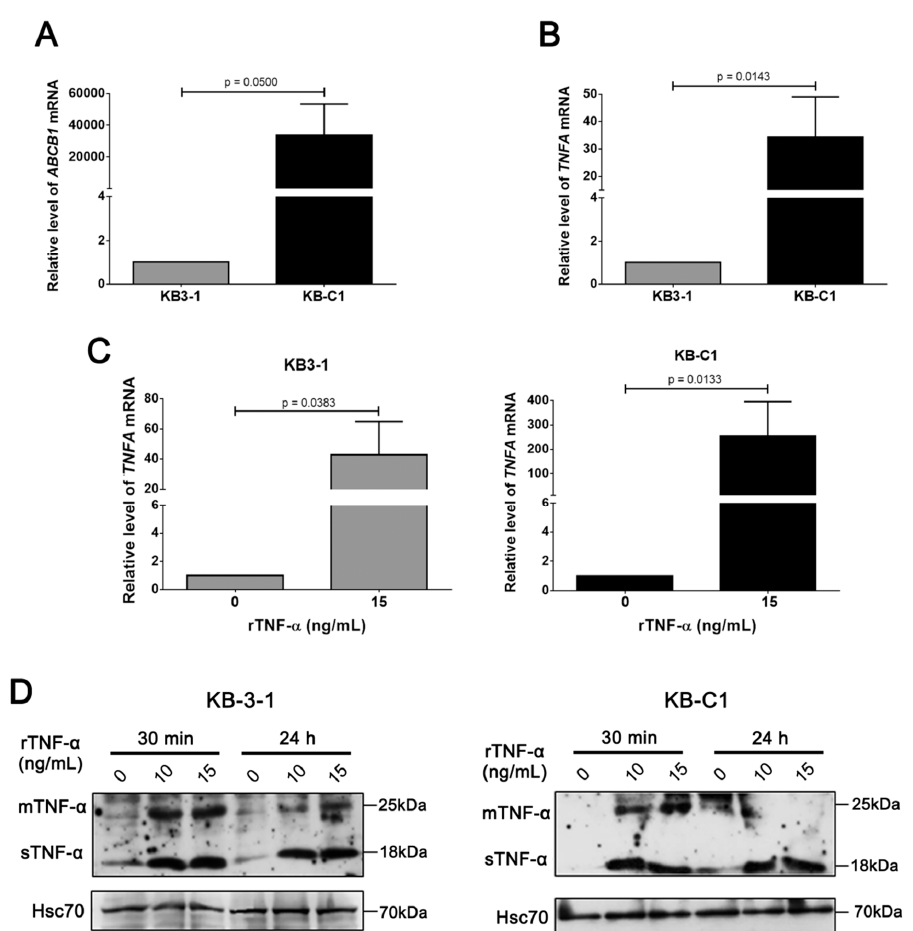
Figure 2. Endogenous TNF- α expression levels in parental and MDR cell lines after recombinant TNF- α treatment. Comparison between KB-3-1 and KB-C1 cells in ( A ) ABCB1 and ( B ) TNFA mRNA levels determined by real time quantitative PCR (qRT-PCR). ( C ) TNFA mRNA levels after 24 h of 15 ng / mL rTNF- α treatment determined by qRT-PCR. ( D ) Immunoblot analysis of endogenous TNF- α protein levels after 30 min or 24 h of 10 or 15 ng / mL rTNF- α treatment (transmembrane—tmTNF- α ; soluble—sTNF- α forms). * p < 0.05 indicates the statistical significance of data compared with non-treated cells. Data are means ± SD of three independent experiments. * p < 0.05; ** p < 0.01 indicates the statistical significance of data compared with parental or non-treated cells. t -test was used to analyze the qRT-PCR results.